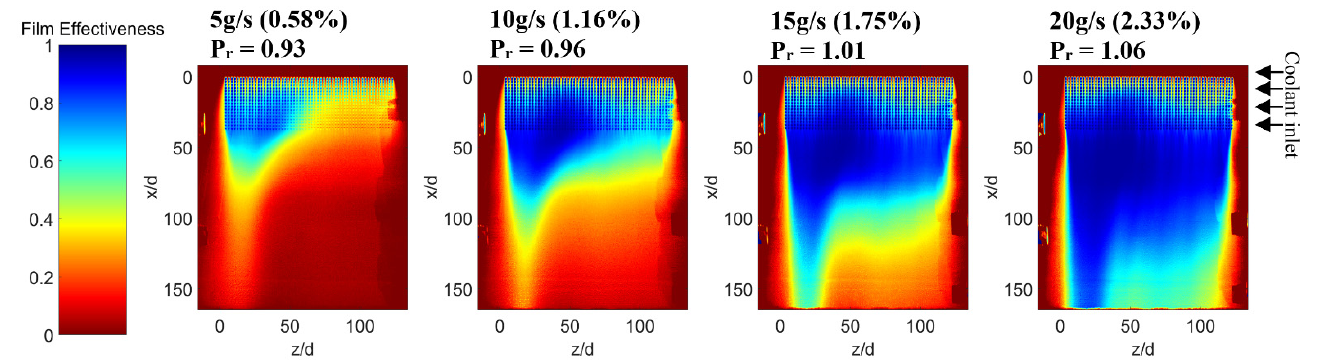
Int. J. Turbomach. Propuls. Power 2021 , 6 , x FOR PEER REVIEW 7 of 13